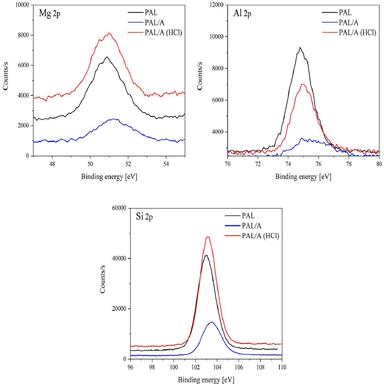
X-ray photoelectron spectra of Mg 2p, Al 2p, and Si 2p transitions acquired for the pure palygorskite mineral, hybrid pigment, and hybrid pigment exposed to HCl.